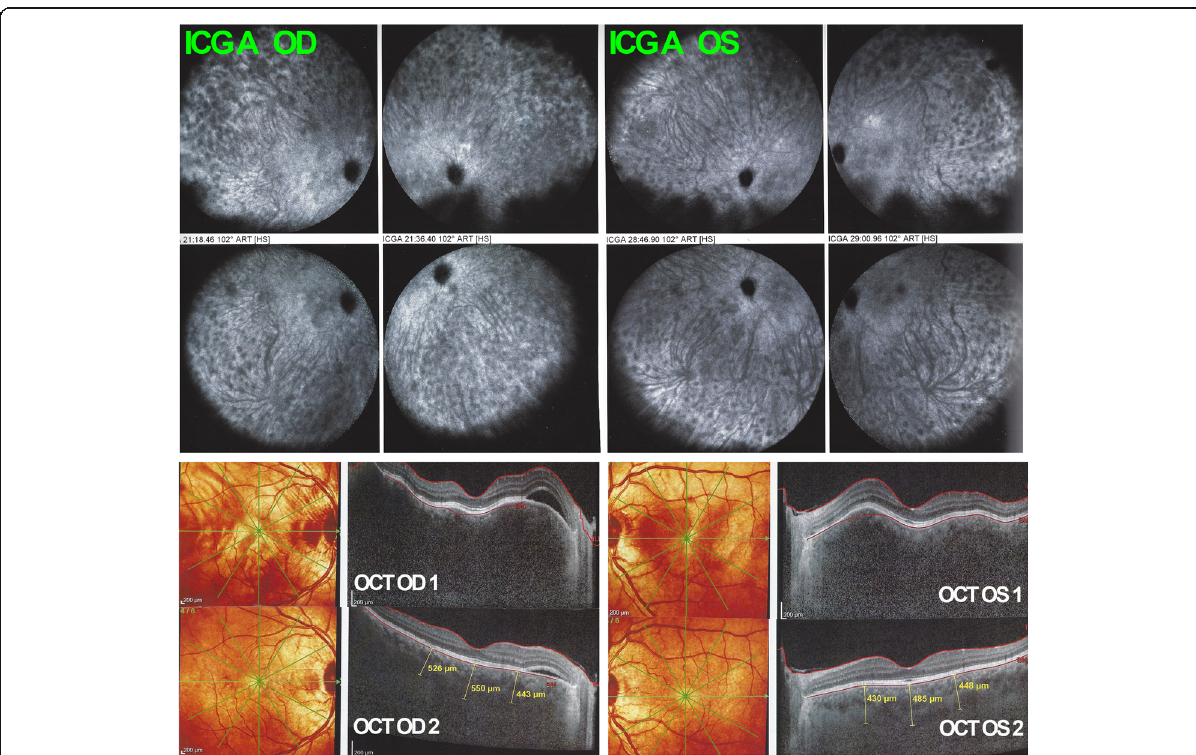
Fig. 6 Recurrence of VKH after the second dose of anti-SARS-CoV-2 vaccination. On ICGA, numerous HDDs ODS dispersed over both fundi are present. OCT shows exudative retinal detachments and markedly thickened choroid not measurable OCT OD1 and OCT OS1. Thickness decreased substantially after 5 days of oral corticosteroids to 506 ± 50 μ m OD and 454 ± 28 μ m OG (OCT OD 2 & OCT OD